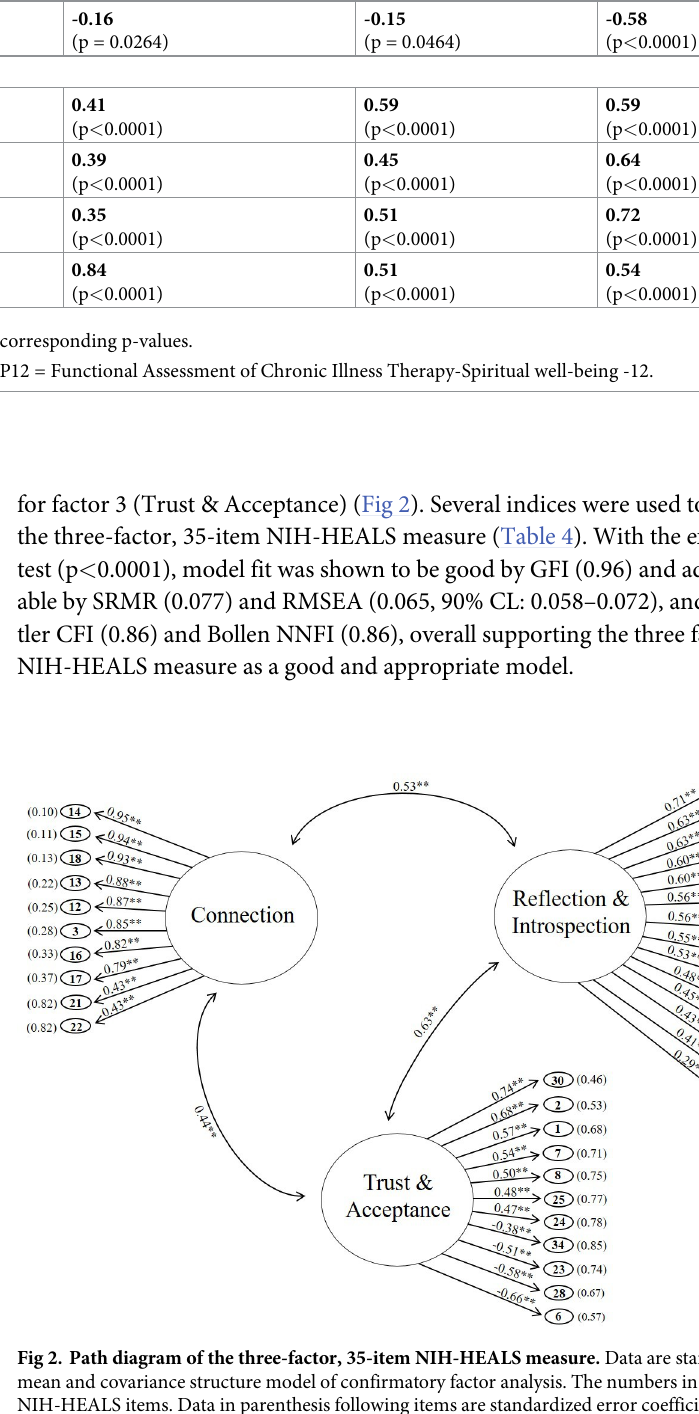
Table 3. Divergent and convergent validity results for the three-factor, 35-item NIH healing experience of All Life Stressors (NIH-HEALS) measure.